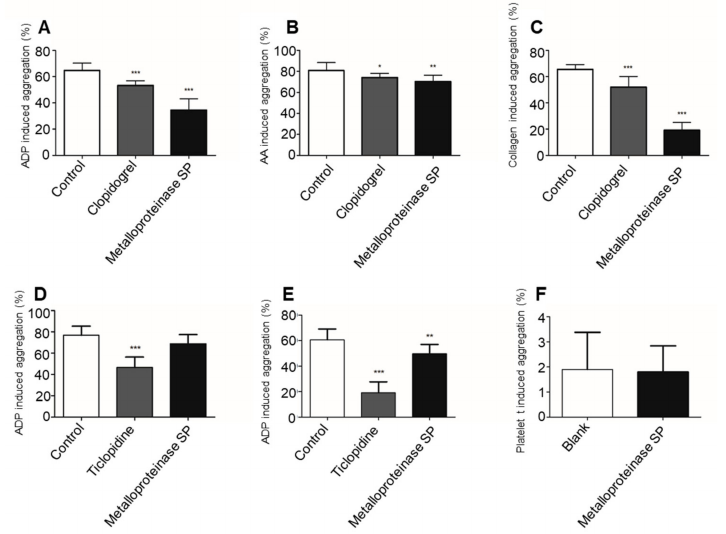
Figure 5. The in vitro and in vivo anti-platelet aggregation activity of metalloproteinase SP. ( A ) Compared with the blank group, the clopidogrel and the metalloproteinase SP groups specifically inhibited ADP-induced platelet aggregation. Metalloproteinase SP inhibited ADP-induced platelet aggregation with an inhibition rate of 44.28%. ( B ) Metalloproteinase SP inhibited AA-induced platelet aggregation with an inhibition rate of 13.19%. ( C ) Metalloproteinase SP inhibited collagen-induced platelet aggregation with an inhibition rate of 71.09%. The anti-platelet aggregation activity of metalloproteinase SP in vitro. ( D , E ) Metalloproteinase SP exhibited a dose-dependent inhibition of the ADP-induced aggregation of PRP. Compared with blank group, 0.5 µ g of metalloproteinase SP significantly inhibited ADP-induced platelet aggregation with an inhibition rate of 18.27%. ( F ) Metalloproteinase SP not exhibited the promoted platelet aggregation activity. All data were expressed as mean ± SD, compared with the blank control group, * p < 0.05, ** p < 0.01, *** p <